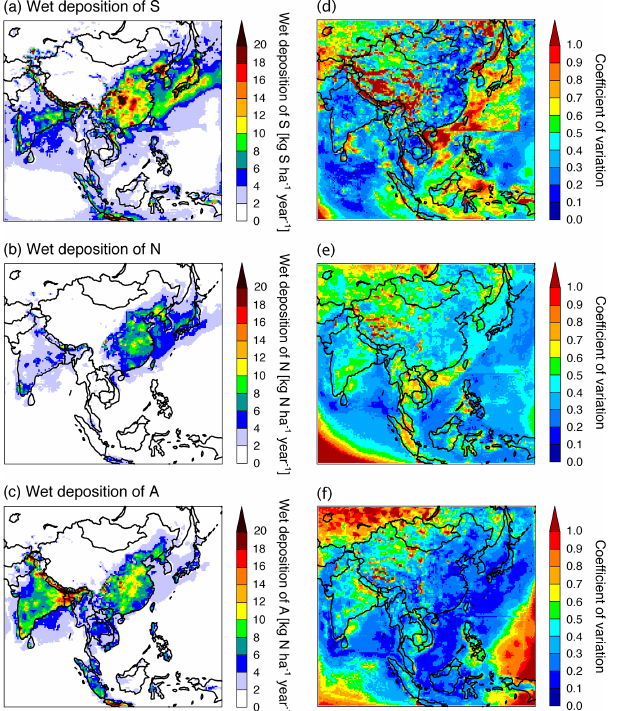
Figure 13. (a–c) Spatial distributions of the weighted ensemble mean for the wet deposition of (a) S, (b) N, and (c) A. (d–f) Differ- ences between the ensemble mean and the weighted ensemble mean (calculated as ensemble mean – weighted ensemble